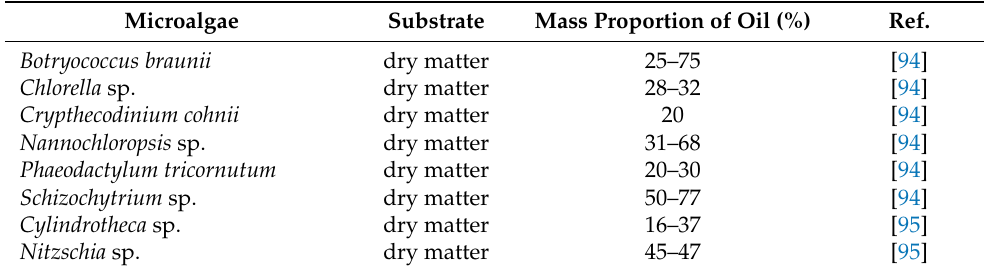
Table 2. Lipid yields from different microalgae.